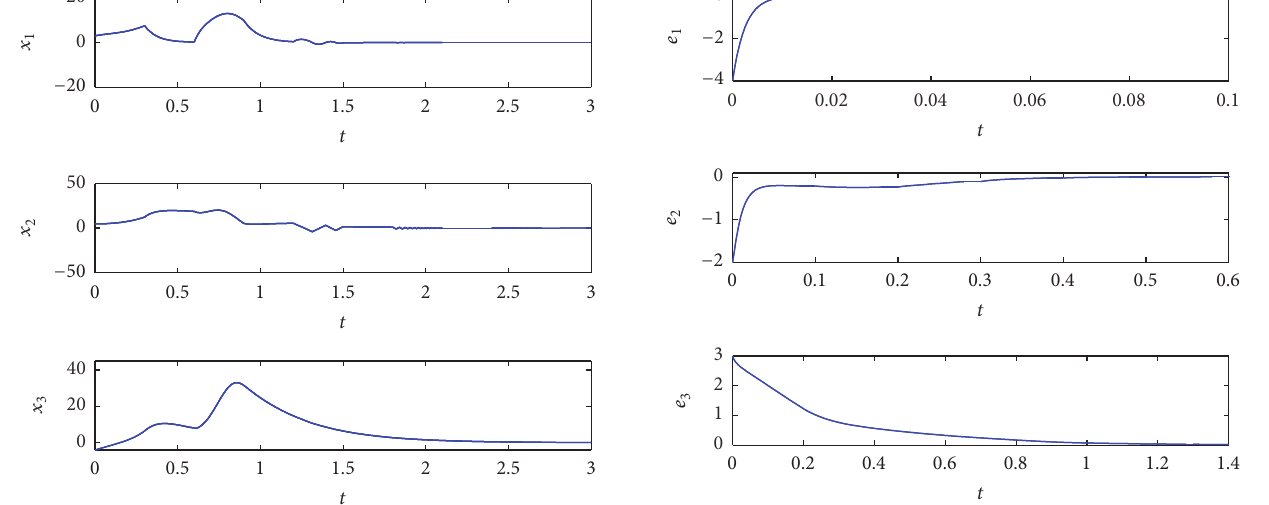
Figure 4: Plots of synchronization errors between systems (23) and (45).